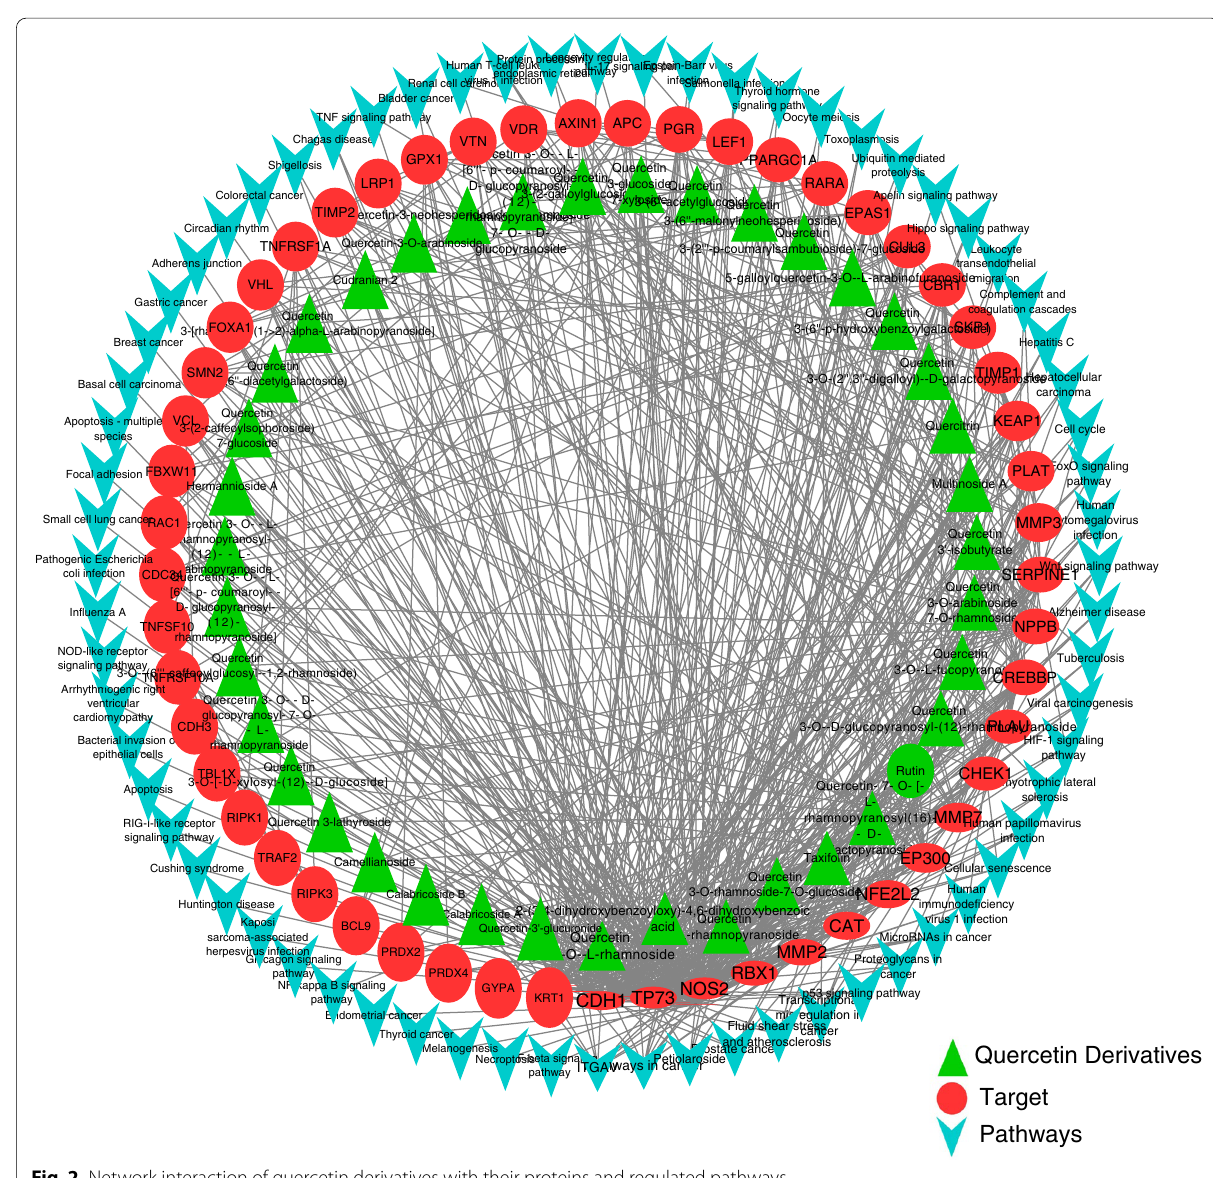
Fig. 2 Network interaction of quercetin derivatives with their proteins and regulated